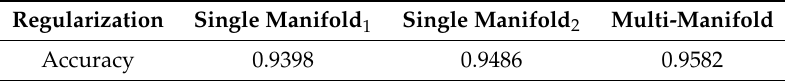
Table 3. The recognition accuracies obtained using different